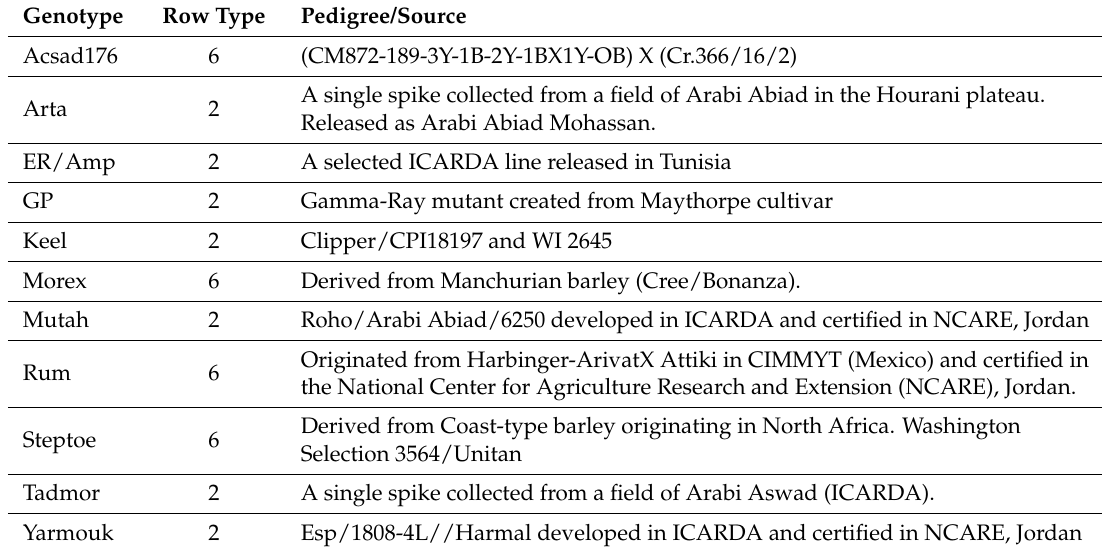
Table 1. Names and origin of genotypes used in this